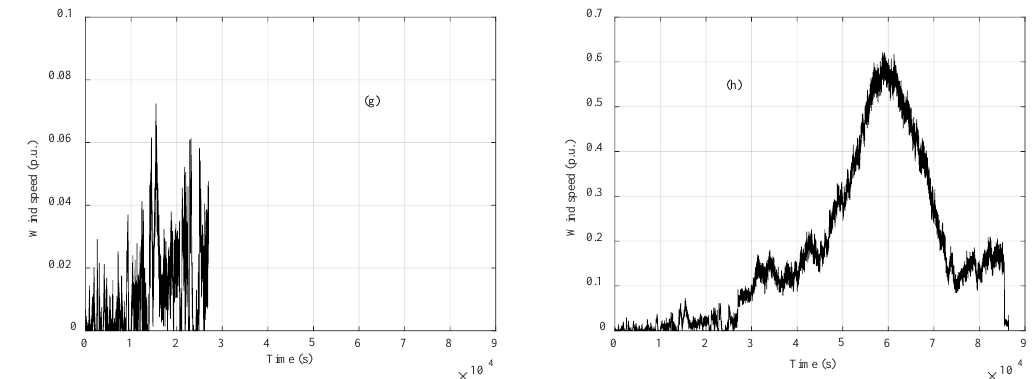
Figure 15. Examples of incomplete data filling: ( a ) Incomplete day 01/11/2013; ( b ) Completed day 01/11/2013; ( c ) Incomplete day 01/12/2013; ( d ) Completed day 01/12/2013; ( e ) Incomplete day 19/06/2013; ( f ) Completed day 19/06/2013; ( g ) Incomplete day 27/07/2013; ( h ) Completed day 27/07/2013.